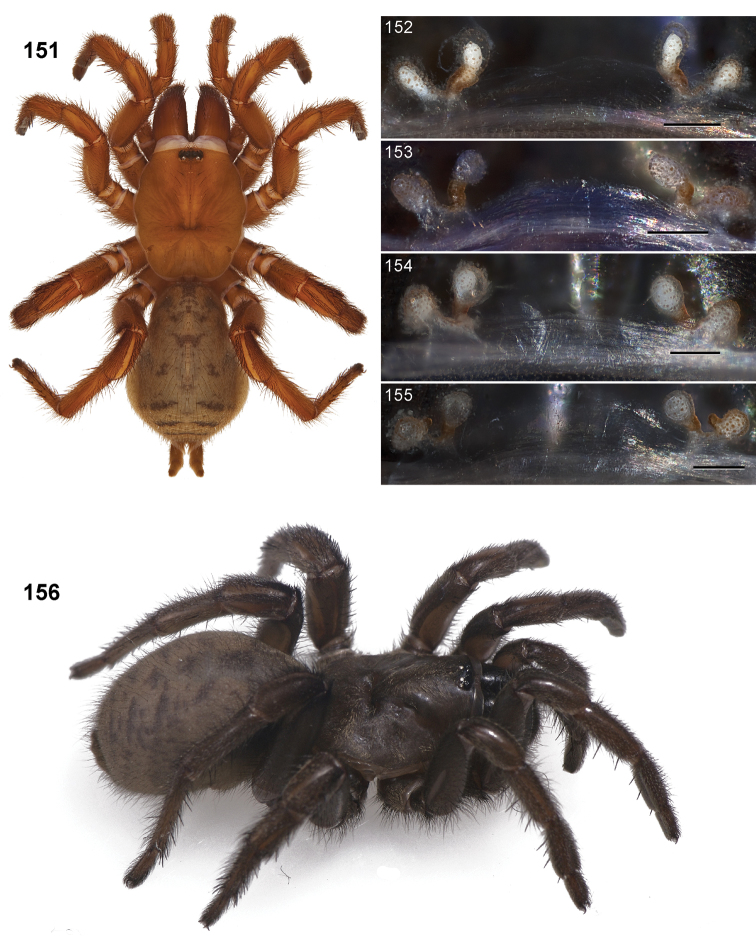
Aptostichus icenoglei sp. n. female. 151 habitus, female paratype from Riverside Co., Winchester (AP391) [805876] 152–155 cleared spermathecae of specimens (MY0718, 2465, 2467, 2505) from Riverside and San Diego Counties [806579, 806582, 806585, 806588]; scale bars = 0.1mm. 156 live photograph of specimen (MY3759) from Los Angeles Co.